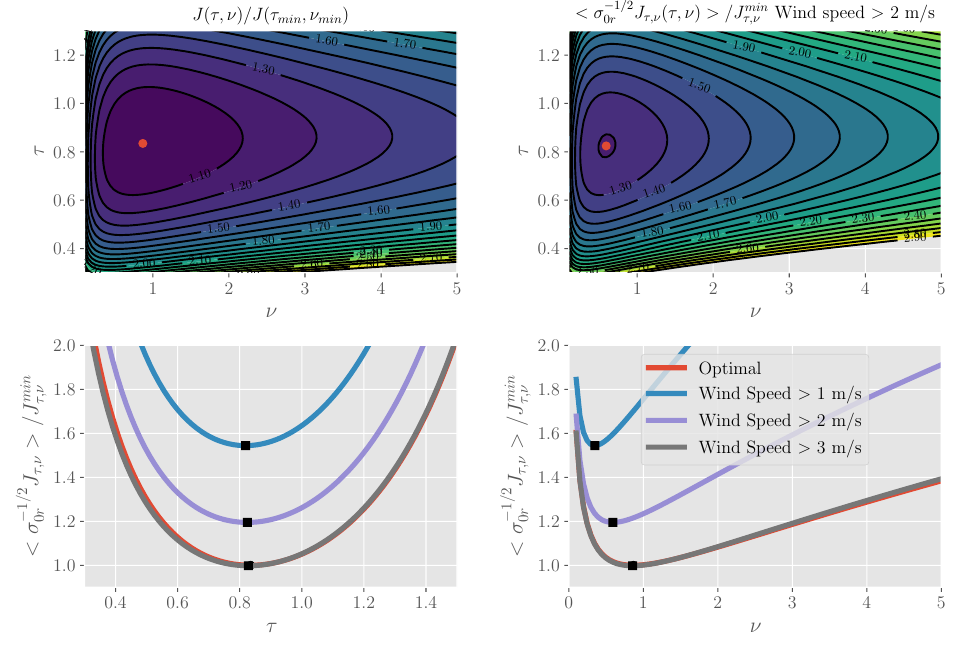
Figure 4. (Upper row) Two dimensional of the optimal function as a function of ν and τ for Equation(25) ( left ) and for the wind averaged case ( right ), Equation(34), choosing a threshold wind speed of 2m/s (c.f., Section3). (lower row) Cross sections at optimal ν (left) and optimal τ (right) for the optimal case (red), and for various lower wind-speed thresholds: of 1m/s (aqua), 2m/s (magenta), and 3m/s